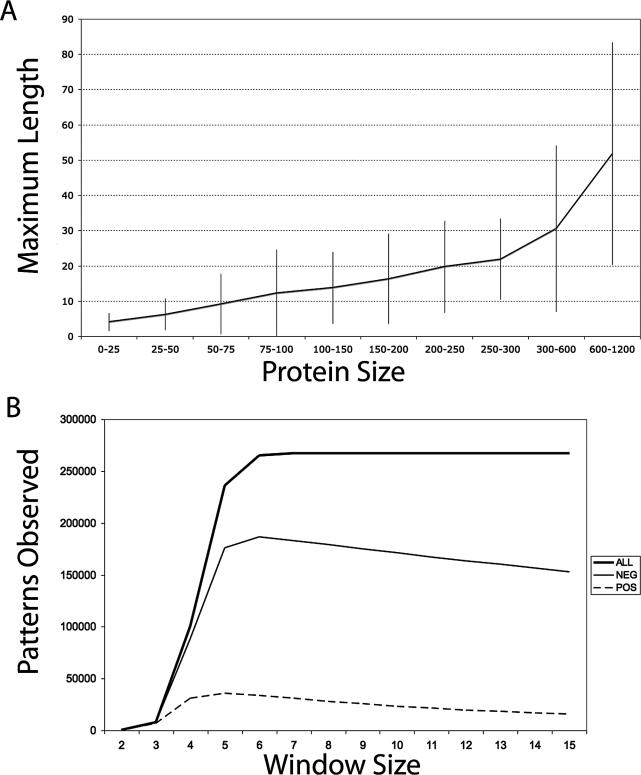
Preliminary Analysis of FFR as Identified by FF Score(A) The average of all maximal FFR lengths plotted against overall protein length.(B) The number of different sequence patterns observed for a given window size. Shown are the pattern counts for regions classified as FFR (dash line), non-FFR (thin line), and irrespective of classification (thick line). FFR regions sample a smaller sequence space compared to non-FFR regions. Patterns overlapping boundaries of FFR and non-FFR are excluded from these counts.